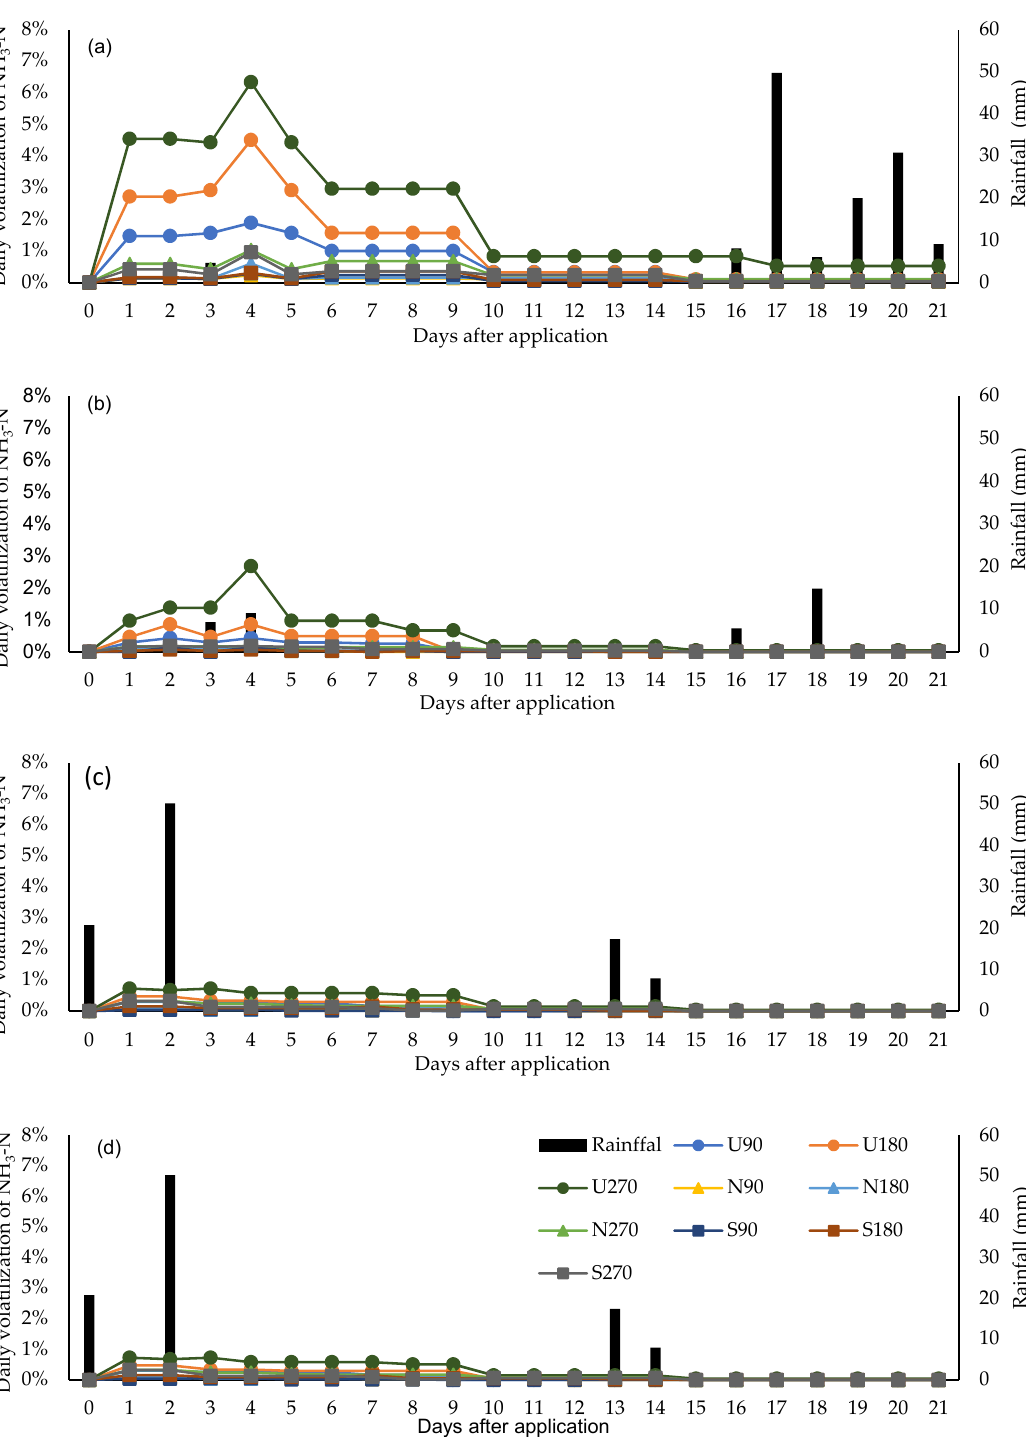
Figure 2. Daily ammonia volatilization in marandu palisade grass pastures under fertilization with fertilizers and doses of N. ( a ) experiment 1, single application ( b ) experiment 2, 1st fertilization, ( c ) experiment 2, 2nd fertilization, and ( d ) experiment 2, 3rd fertilization. U: urea, N: ammonium nitrate, S: ammonium sulfate.